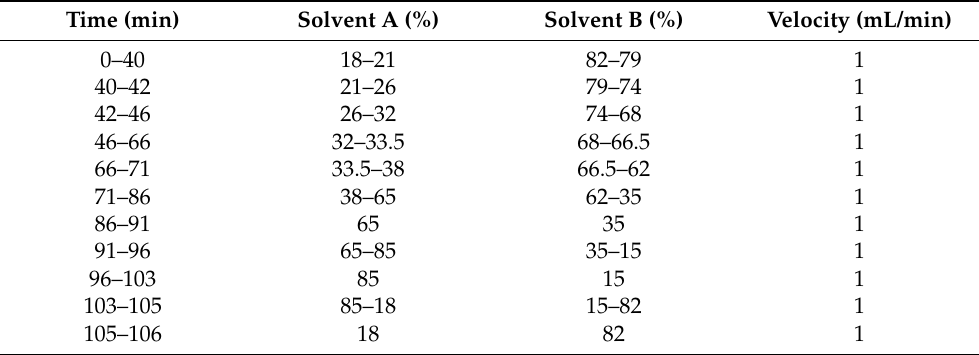
Table 1. Mobile phase gradient condition table for